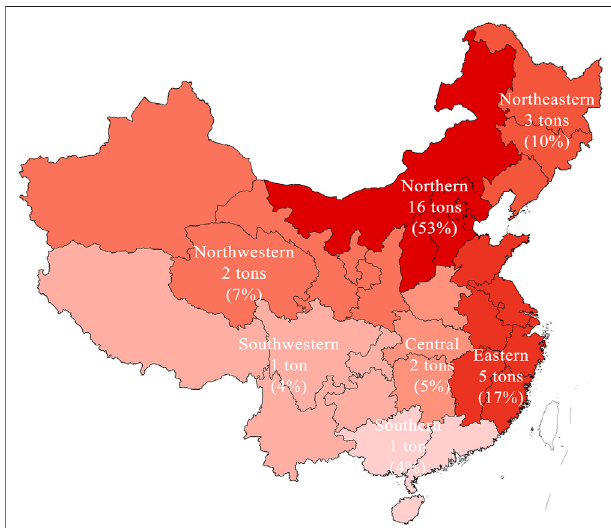
FIGURE6| Contributionsofsludge-bornetotalHgfromdifferentregions of China in 2019. The total estimated amount is 30 tons for the entire country.